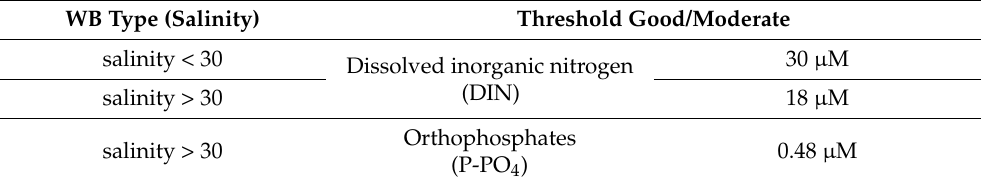
Table 1. Thresholds set for physicochemical quality elements supporting biological elements by national legislation for the implementation of WFD (MD